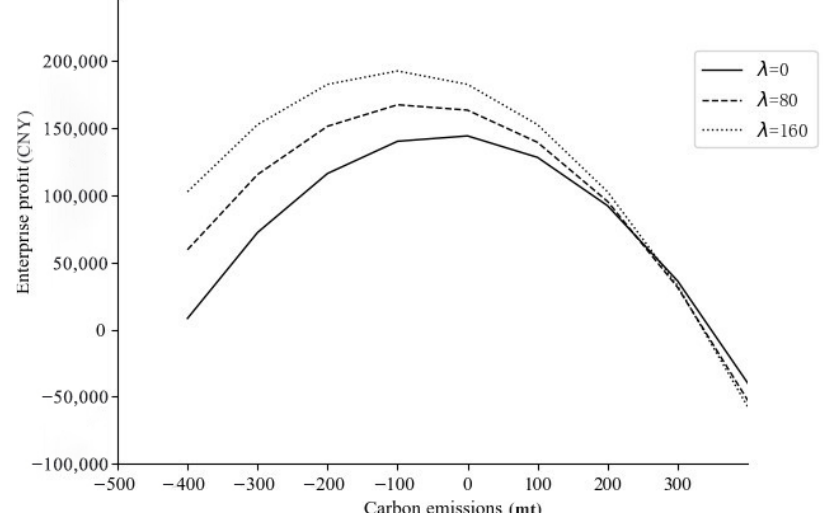
Figure 6. The impact of carbon emissions on corporate profits under different carbon trading prices.